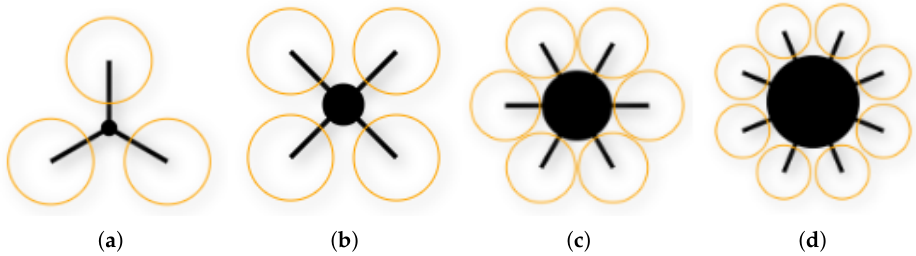
Figure 2. Graphical representation of the setups considered in the design phase. The elements in these figures are not in scale. ( a ) S3A-C. ( b ) S4A-C. ( c ) S6A-C. ( d )